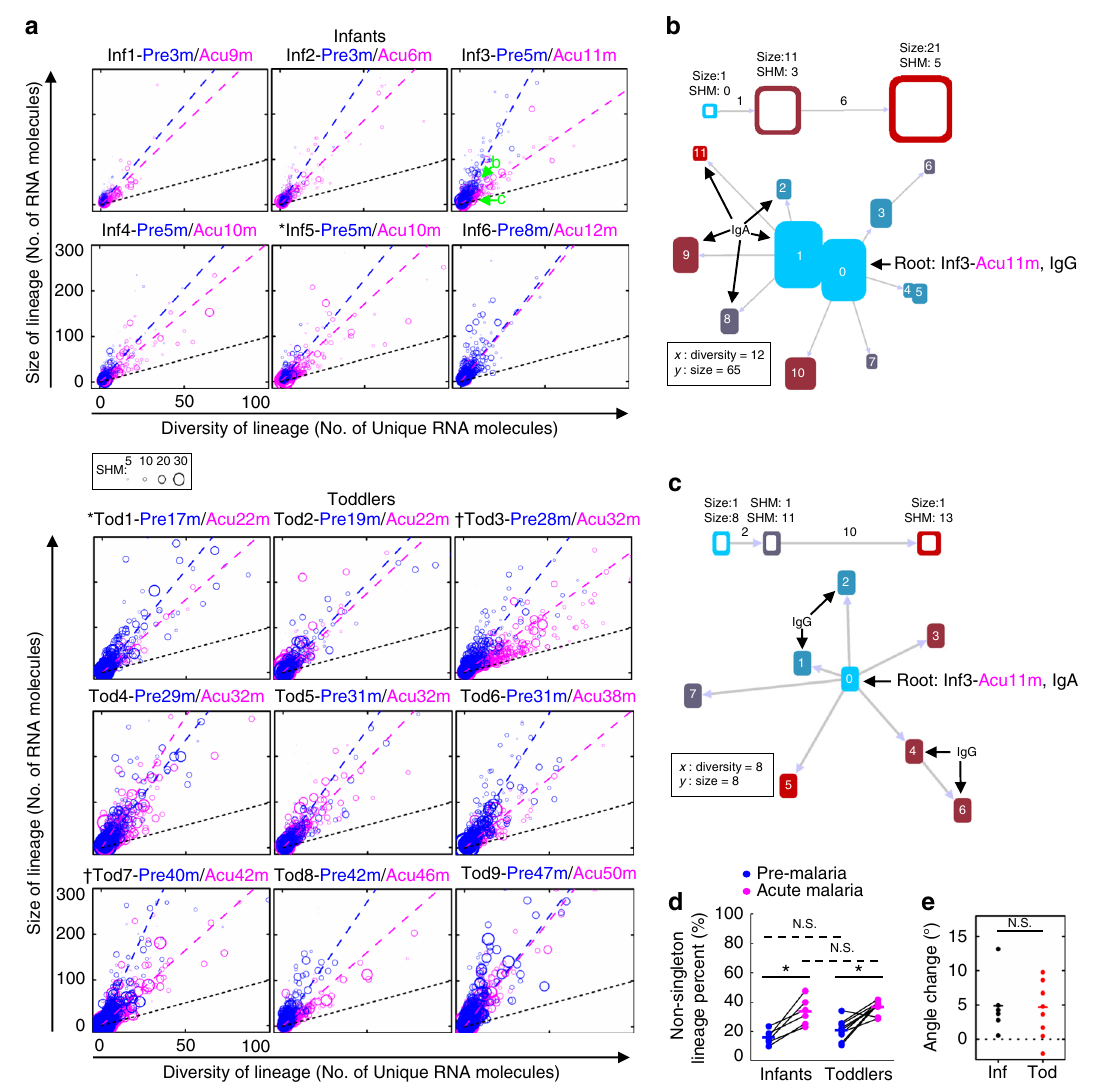
Fig. 5 B cell lineage complexity change under malaria stimulation. a Diversity and size of B cell lineages for infants ( N = 6) and toddlers ( N = 9) from whom paired PBMC samples at pre-malaria ( blue ) and acute malaria ( pink ) were obtained. Each circle represents an individual lineage. The area of each circle is proportional to the SHM load. Labeled green arrows indicate representative lineages whose intra-lineage structures were shown in detail in ( b ) and ( c ). Each circle ’ s x and y coordinates were determined by its diversity (the number of unique RNA molecules in a lineage) and size (the number of total RNA molecules in a lineage), respectively. Blue and pink dashed lines represent the linear fi t for pre-malaria and acute malaria lineages, respectively. Black dashed lines indicate y = x parity, such that lineages lying on the parity line are comprised entirely of unique RNA molecules with minimum clonal expansion, such as lineage in ( c ). On the other hand, lineages comprised of clonally expanded RNA molecules are close to the y axis, such as lineage ( b ). b , c Each node is a unique RNA molecule species. The height of the node corresponds to the number of RNA molecules of the same species, the color corresponds to number of nucleotide mutations, and the distance between nodes is proportional to the Levenshtein distance between the node sequences, as indicated in the legend above each lineage. All unlabeled nodes share the isotype with the root. d The non-singleton lineage percent (lineages comprises at least two RNA molecules) between infants and toddlers at pre-malaria ( blue ) and acute ( pink ) malaria. * P < 0.05 by two-tailed Wilcoxon signed-rank test (between time points, solid lines ); N.S. indicates no signi fi cant difference by two-tailed Mann – Whitney U test (between age groups, dashed lines ). e The difference of linear regression slopes ( angles ), or degree of diversity change, between pre-malaria and acute malaria for infants ( black ) and toddlers ( red ). N.S. indicates no signi fi cant difference by two-tailed Mann – Whitney U test. Bars indicate means. Differences in variance were not signi fi cant by squared ranks